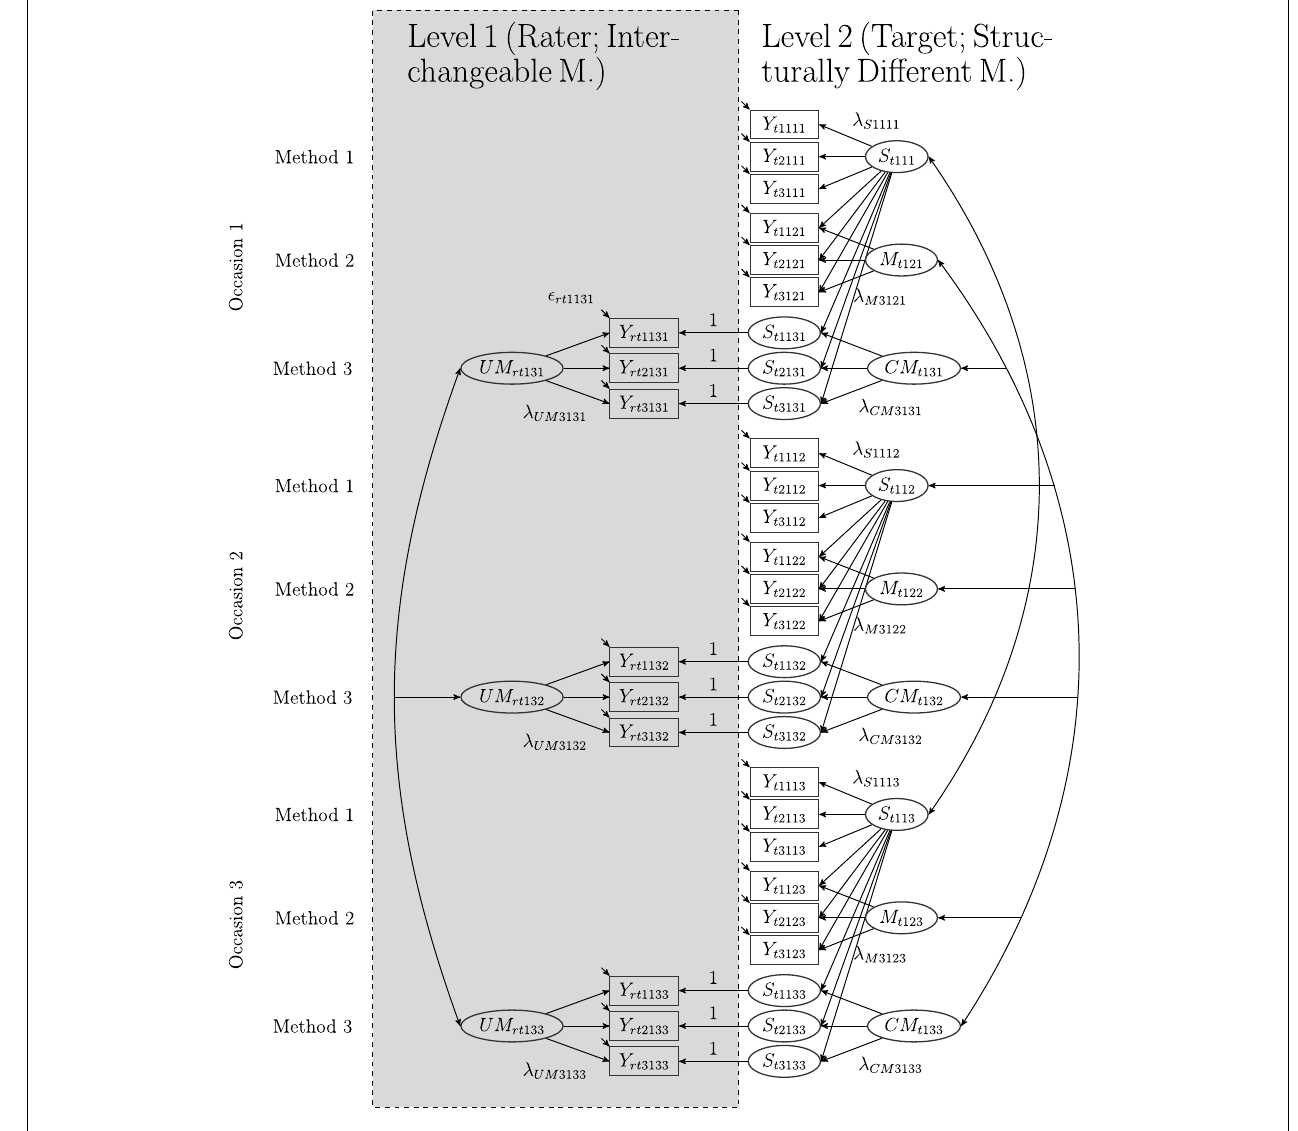
loadings, CM tjkl : latent common method factors, λ CMijkl : common method factor loadings, UM rtjkl : latent unique method factors, λ UMijkl : unique method factor loadings, (cid:2) rtijkl : measurement errors at Level 1, and (cid:2) tijkl : measurement errors at Level 2. Intercepts ( α ijkl ) are not depicted in the figure. In this example, one of the structurally different methods (Method 1) serves as reference